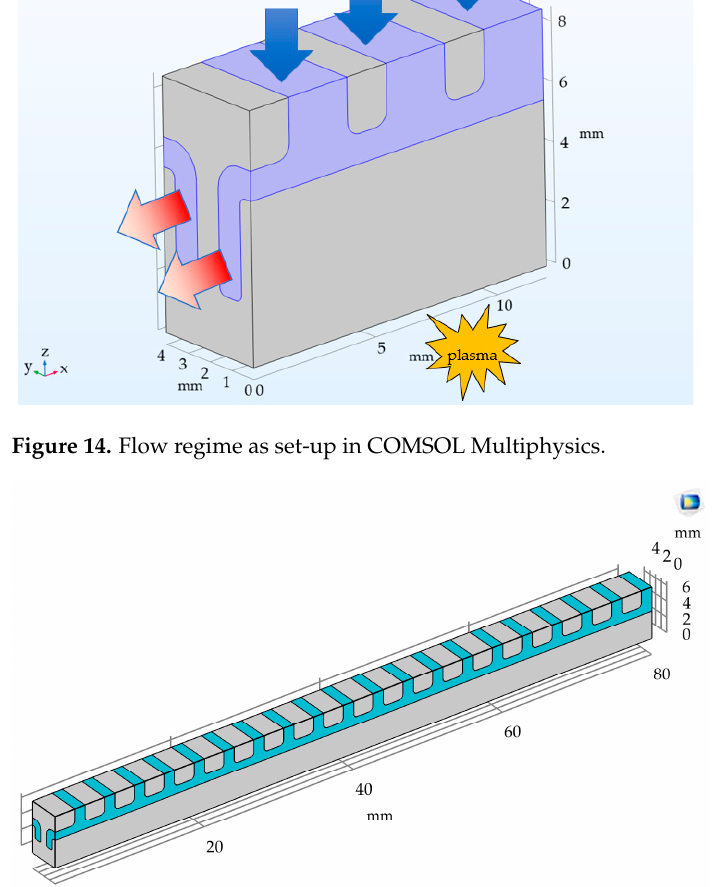
Figure 15. Example of a 20-inlet geometry.